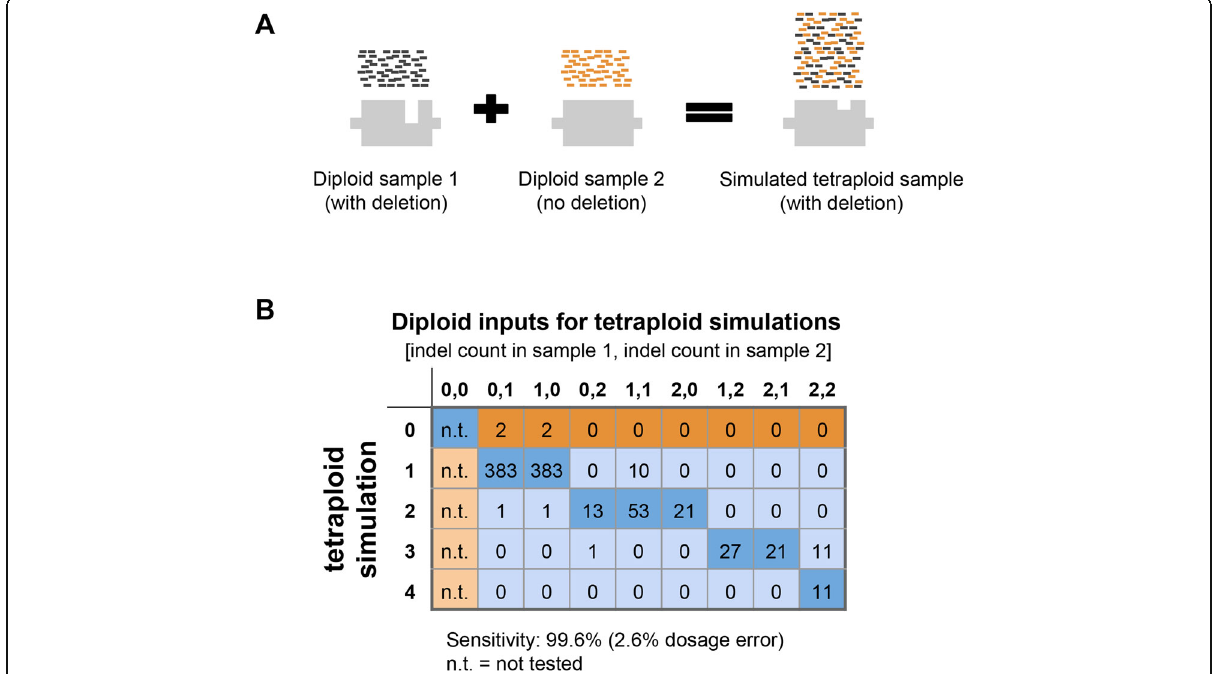
Fig. 4 Simulated indels increase confidence in indel sensitivity. a Schematic of simulating a tetraploid indel by combining sequencing data from two diploid samples. b Results of tetraploid indel simulations in the same format as Fig.